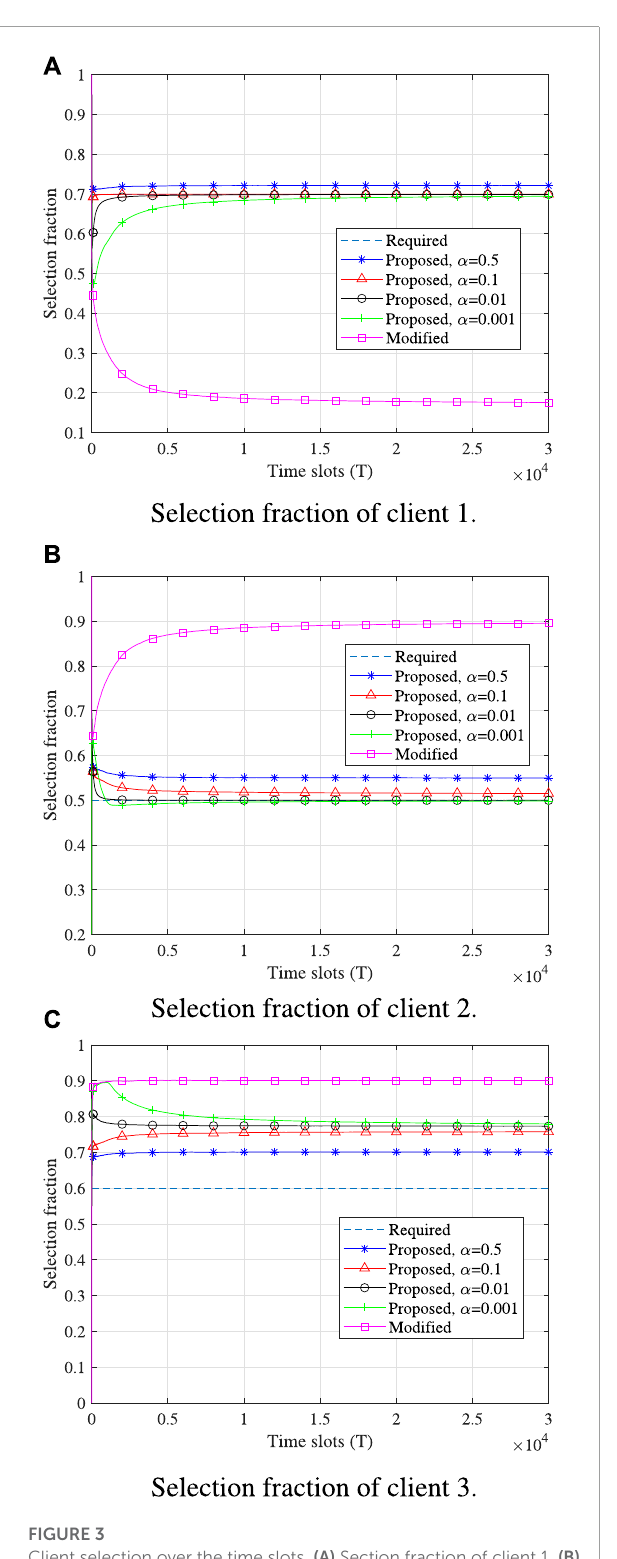
FIGURE 3 Client selection over the time slots. (A) Section fraction of client 1. (B) Section fraction of client 2. (C) Section fraction of client 3.